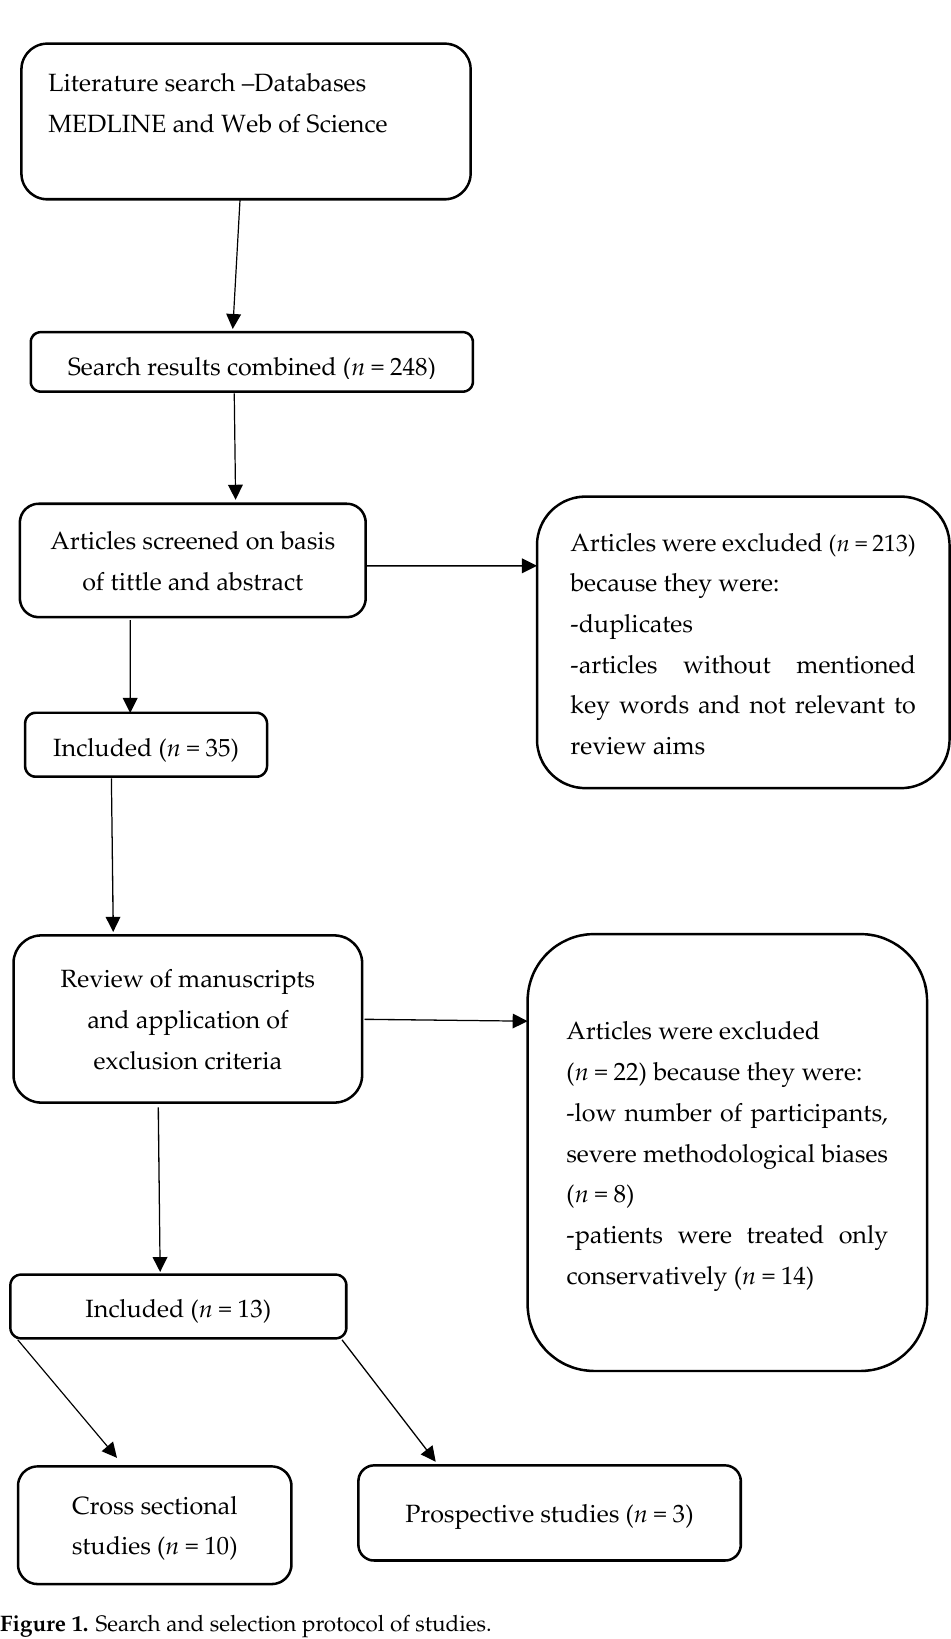
Figure 1. Search and selection protocol of